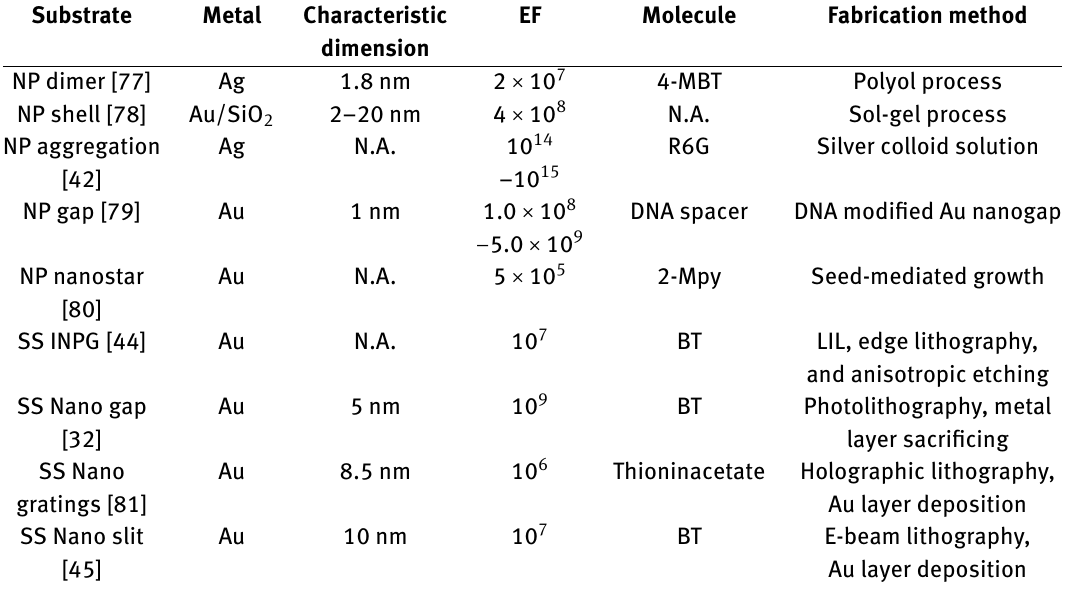
Table 2: Performance comparison of some SERS structures. NP: nanoparticle; SS: solid substrate; 4-MBT: 4-methyl benzenthiol; 2-Mpy: 2-methyl pridine; N.A.: not described in the